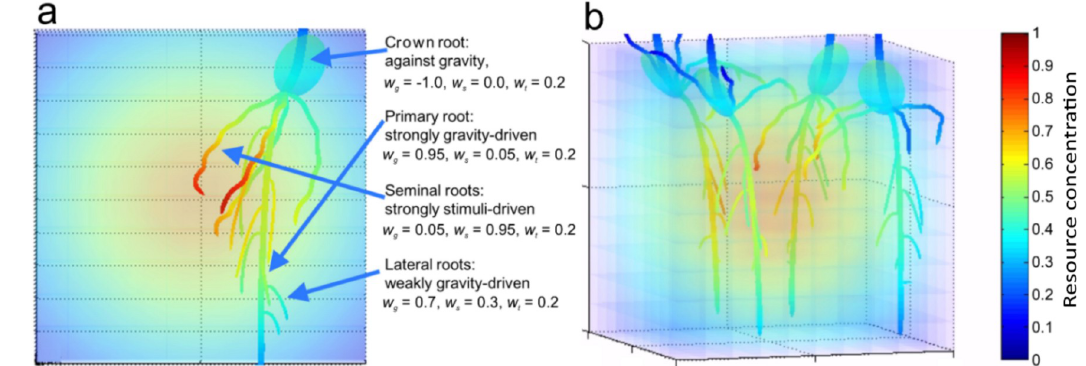
Fig 7. An example of root specialization. We investigated whether the complex ramification of the plant root systems could be approximated by the same relatively simple model for each root type, but with different root-specific (e.g., primary, secondary, crown roots) and task-specific (e.g., gravity-, resource-sensitive) parameter values. (a) Different roots (crown, primary, seminal and lateral roots) initialized with different sensitivity to gravitropic w g , thigmotropic w t , and resource w s signals to very roughly approximate their possible behavior (e.g., the crown is initialized with negative gravitropism and upward growth by setting w seminal roots could be stimulated to circumnutate towards better environmental conditions barely affected by gravity when setting w s = 0.7). All roots could avoid obstacles when setting w t = 0.2. (b) Simulation of root specialization with parameters given in (a). Different kinds of roots were differently affected by the presence of the environmental resource, and the roots with greater w resource concentration C tended to grow towards the middle of the box where the maximum of C scaled between 0 (blue color) and 1 (red